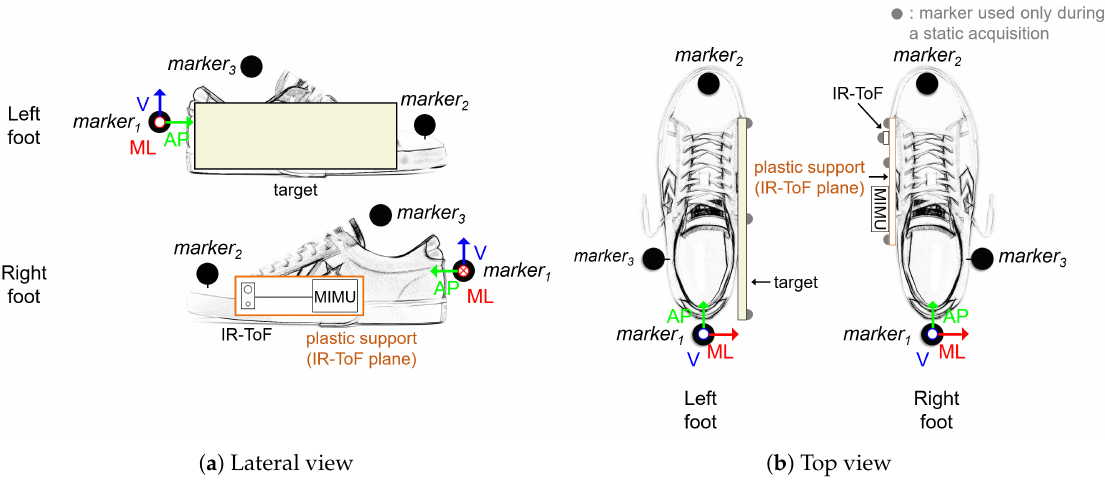
Figure 9. D-MuSe and markers placement on the feet. The origin of the coordinate system was aligned with marker 1